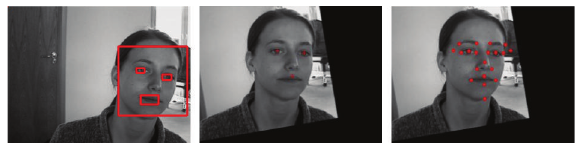
Figure 3: The landmark localization process: (from left to right) detection of face and facial components, normalised face, and fixed set of facial landmarks on the normalised